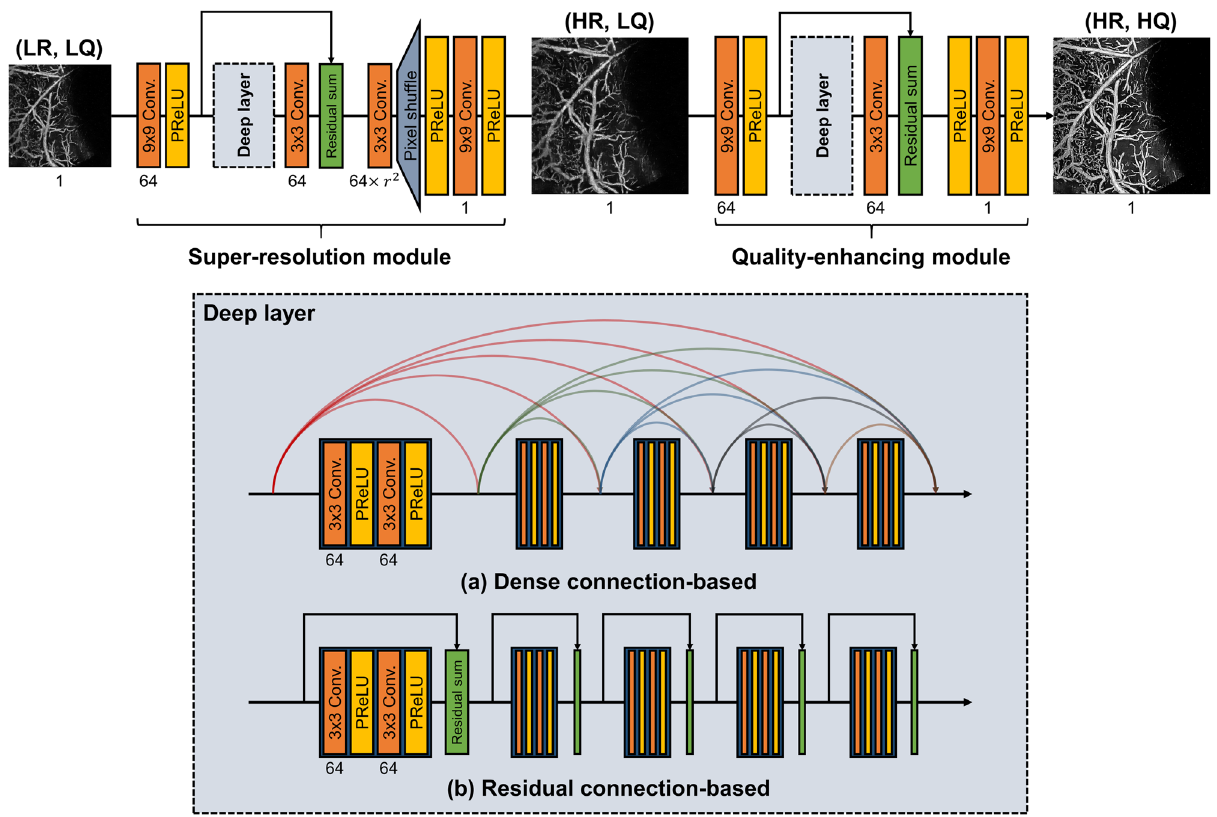
Figure 3. Architectural description of the deep learning (DL) models used in this study: a dense connection- based model ( a ) and a residual connection-based model ( b ). (LR, LQ) low-resolution and low-quality, (HR, LQ) high-resolution and low-quality, (HR, HQ) high-resolution and high quality, PReLU parametric rectified linear